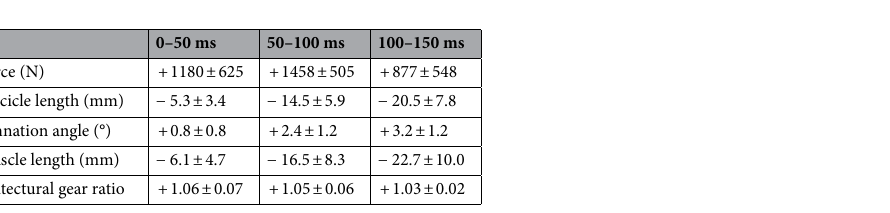
Figure 4. Normalised force–length–velocity potential (mesh), measured values during isometric and isokinetic contractions (green dots), and the relative force–length–velocity values during rapid contractions from force onset to 150 ms post onset for the vastus lateralis muscle shown as 3d-plot (left) and 2d-projections (right). Forces were normalised to maximum force; Fascicle lengths were normalised to optimal fascicle length. Data are mean values (n = 17).